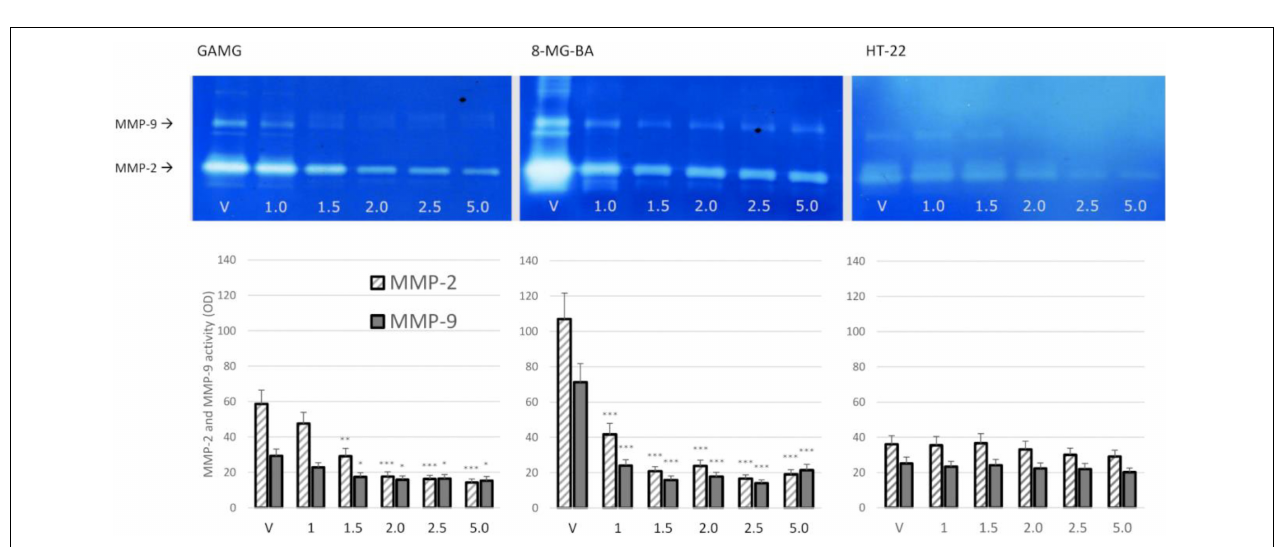
FIGURE 2 | The IC50 values ( µ g/ml) and cells viability (%) regarding GAMG, 8-MG-BA and HT-22 cells after 24, 48, and 72 h of incubation with BV; ** p < 0.01, *** p < 0.001 vs. GAMG, 8-MG-BA and HT-22 vehicle, respectively; Tukey test.